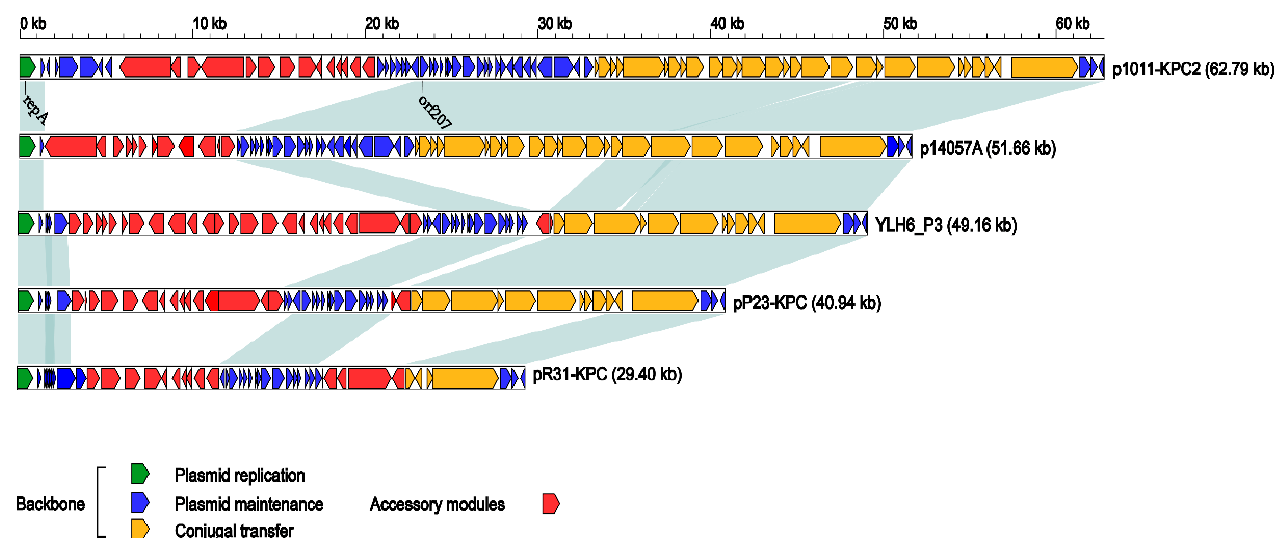
Figure 1. Linear comparison of plasmid genome sequences. Genes are denoted by arrows. The plasmid backbone replication, maintenance, and conjugation regions are colored in green, dark blue, and orange, respectively. The accessory module regions are colored in red. Shading denotes homology (nucleotide identity ≥ 90%) of the plasmid backbone regions, but not the accessory modules. RepA and orf207 represent the names of the labeled genes, respectively. The GenBank accession numbers of p1011-KPC2, p14057A, YLH6_P3, pP23-KPC, and pR31-KPC are MH734334, KY296095, MK882885, CP065418, and CP061851, respectively.